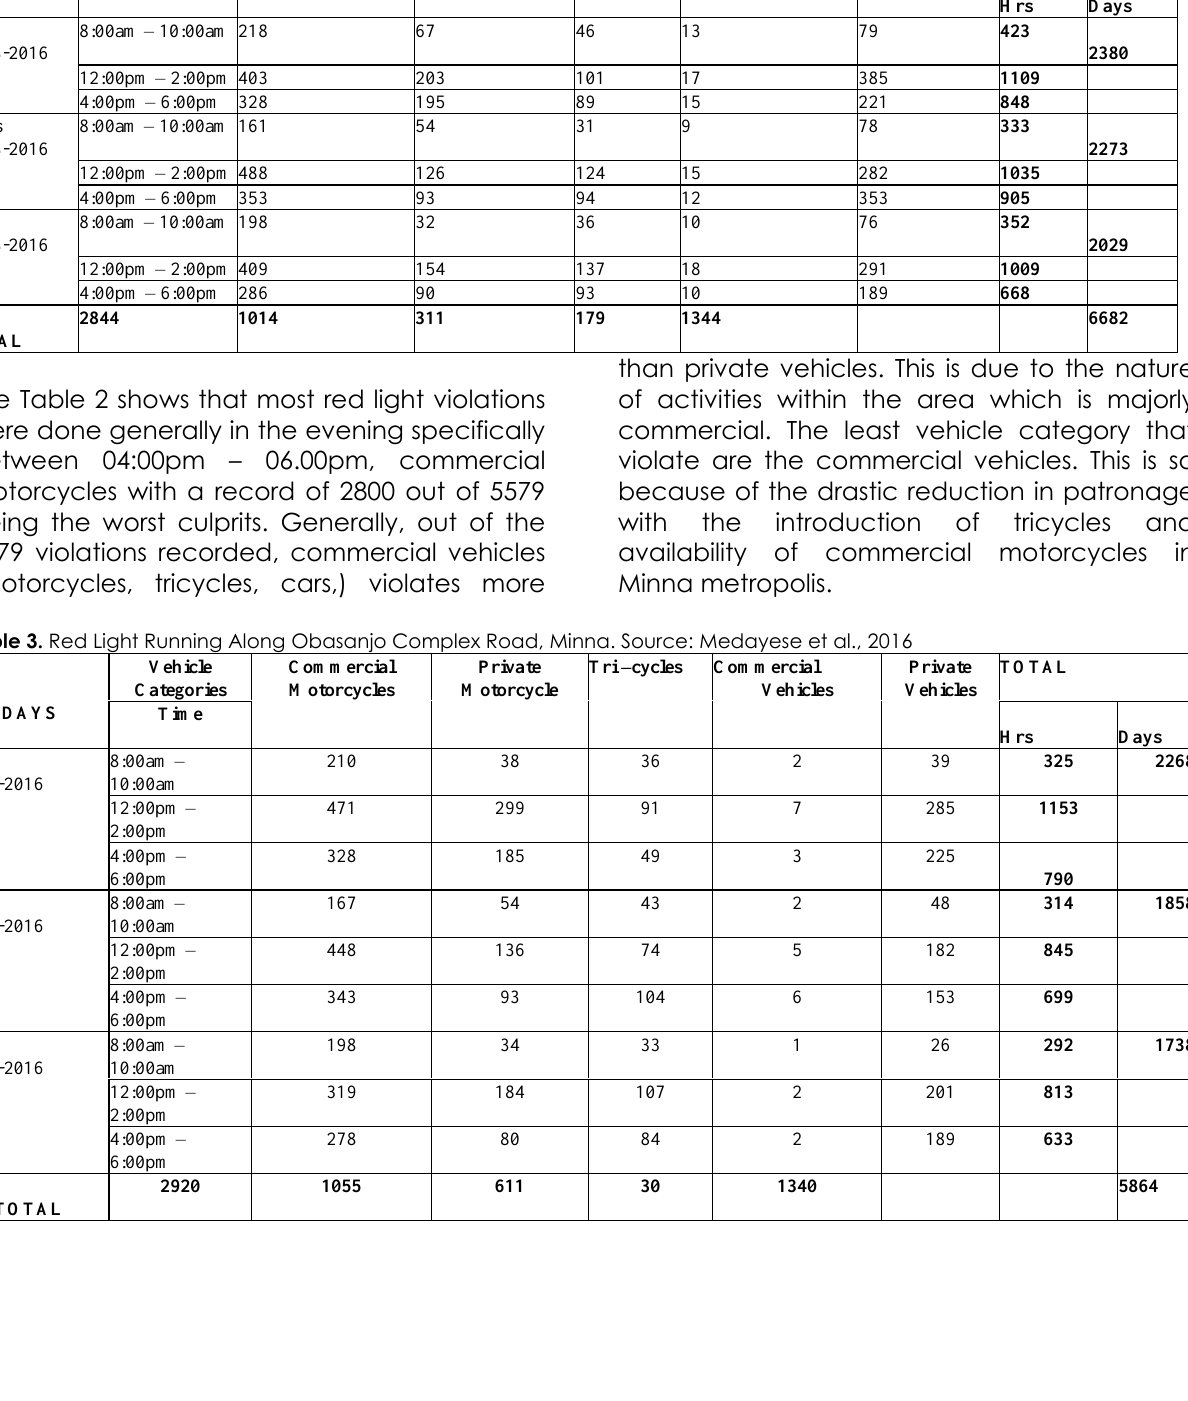
Table 2. Red Light Running Along Top Medical Junction/Paiko Road Intersection. Source: Medayese et al., 2016 Days Vehicle Categories